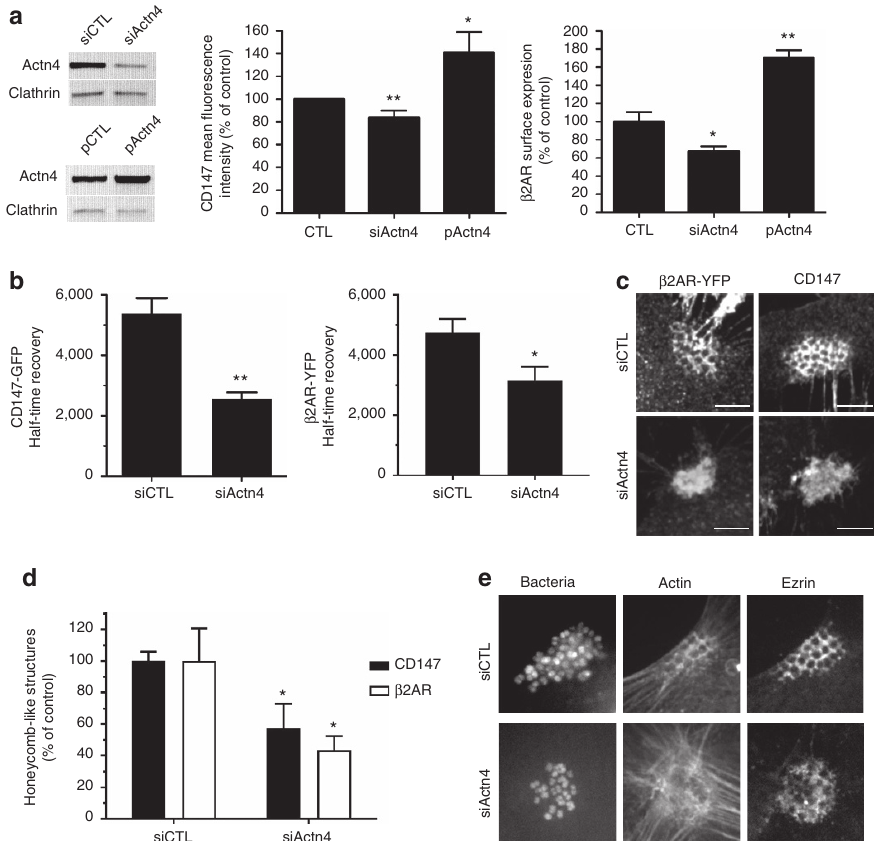
Figure 5 | a -Actn4 governs the distribution and dynamics of CD147– b 2 AR complexes at the cell plasma membrane. ( a ) Actn4 modulates the expression of CD147 and b 2 AR at the cell plasma membrane. HBMECs were transfected with siRNA targeting Actn4 (siActn4), control siRNA (siCTL), plasmid encoding Actn4 (pActn4) or empty vector as a control (pCTL). Actn4 expression was addressed by western blot analysis, using clathrin as a control (left panels), and surface expression of endogenous CD147 was determined by FACS analysis (middle panel). In separate experiments, HBMECs were co-transfected with the same siRNA or plasmids together with a HA- b 2 AR-YFP construct, to address surface expression of b 2 AR using anti-HA antibody in relation to the number of YFP-expressing cells (left panel). Histograms represent the mean fluorescence intensity in relation to the control conditions. Representative FACS plots of these experiments are shown in Supplementary Fig. 6. Mean ± s.e.m., n ¼ 3; * P ¼ 0.05, ** P ¼ 0.01, two-tailed Student’s t -test. ( b ) Actn4 depletion increases the mobility of CD147 and b 2 AR at the cell plasma membrane. HBMECs, co-transfected with CD147-GFP or b 2 AR-YFP and siRNA targeting Actn4 (siActn4) or control siRNA (siCTL), were subjected to FRAP assay. Shown are (left) the halftime recovery of CD147-GFP in n ¼ 18–22 cells per condition and (right) the halftime recovery of b 2 AR-YFP in n ¼ 12–22 cells per condition from four independent experiments. Representative fluorescence images of the FRAP experiments and mean FRAP recovery curves are shown in Supplementary Fig. 7. ( c and d ) Actn4 depletion disrupts the organized assembly of CD147 and b 2 AR at bacterial adhesion sites. ( c ) Confocal analysis of endogenous CD147 or b 2AR-YFP in control (siCTRL) or Actn-4-depleted (siActn4) HBMECs infected for 1h by N. meningitidis (scale bars, 10 m m). ( d ) Percentage of bacterial colonies